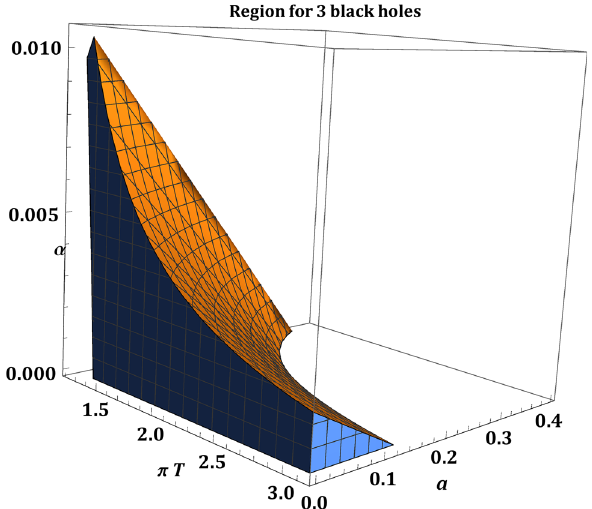
Fig. 2 Temperature vs string cloud density with higher derivative cor- rection ¯ a ¯ r = + O ( ¯ a 2 ). 0 3